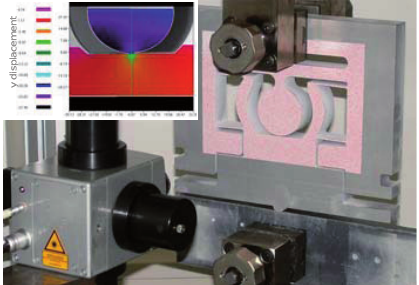
Fig. 3 A physical standardised test material ( EU Community Design Registration 000299094 ) manufactured from aluminium having a disc diameter of 50mm being tested using a ESPI system (Dantec Dynamics Q300) with typical results shown inset. (© SPOTS consortium)